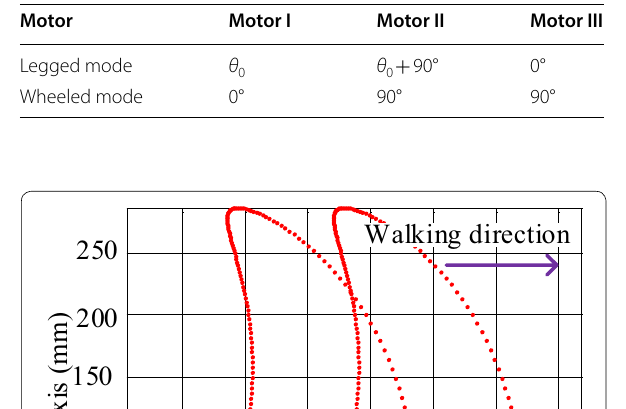
Table 3 Phase relations of motors